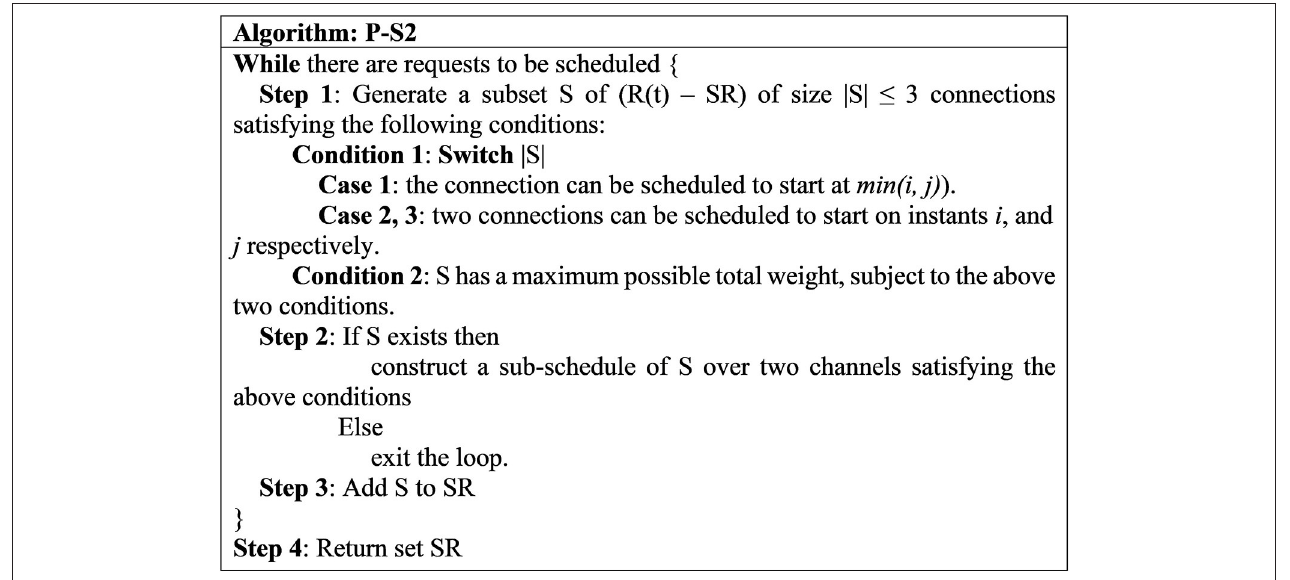
FIGURE 5 | Preemptive scheduling function.